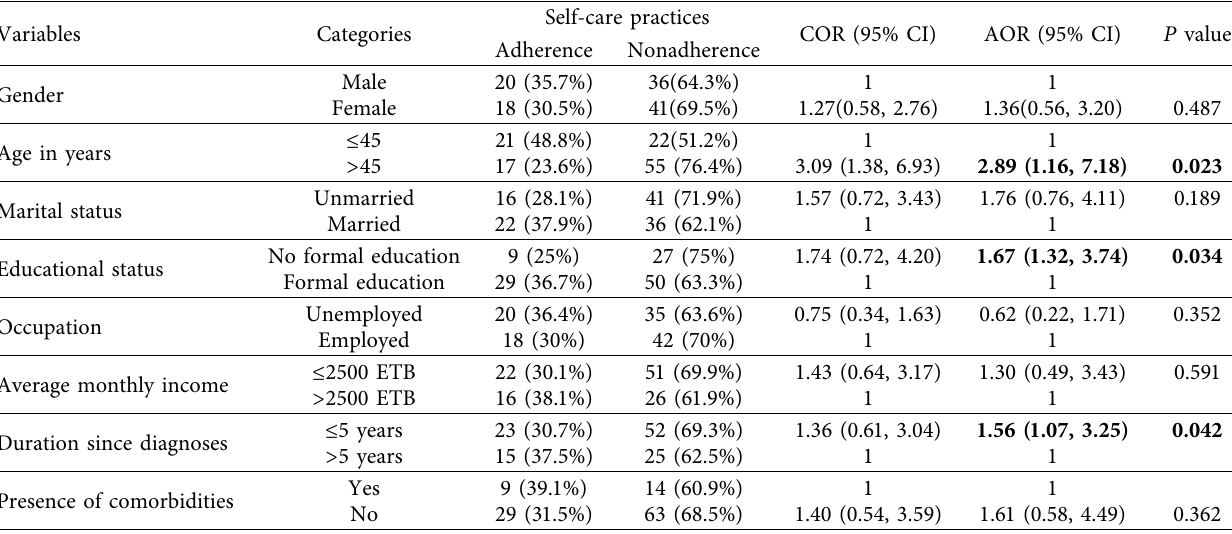
Table 7: Bivariable and multivariable analysis of factors associated with nonadherence to self-care practices among hypertensive patients in a follow-up clinic at Asella Referral and Teaching Hospital, Asella Town, Arsi Zone, Oromia Regional State, Ethiopia, 2020. Variables